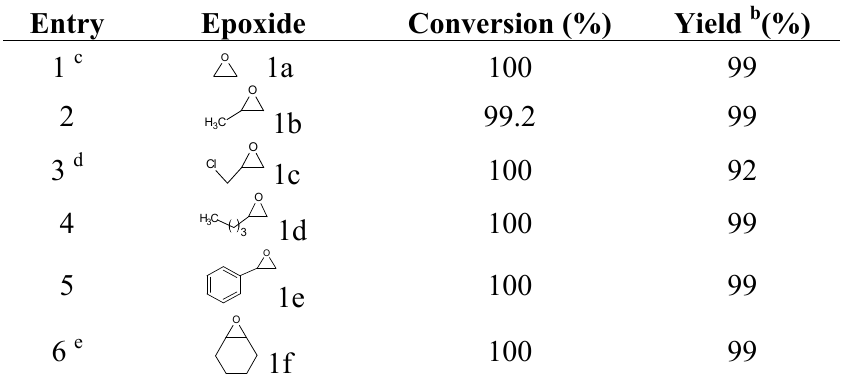
Table 7. Synthesis of different cyclic carbonates catalyzed by HEMIMB a [77,78].